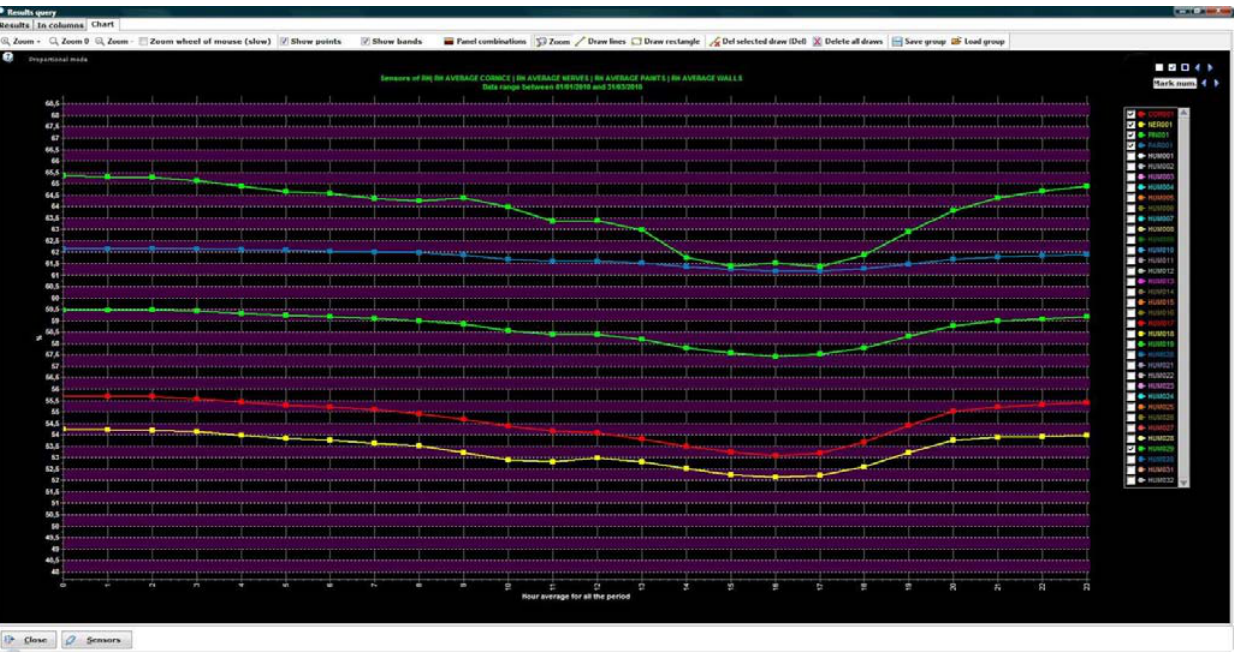
Figure 11. Daily mean trajectories of five sensors (from 01/01/2010 to 03/31/2010). Zoom on the figure for more axis